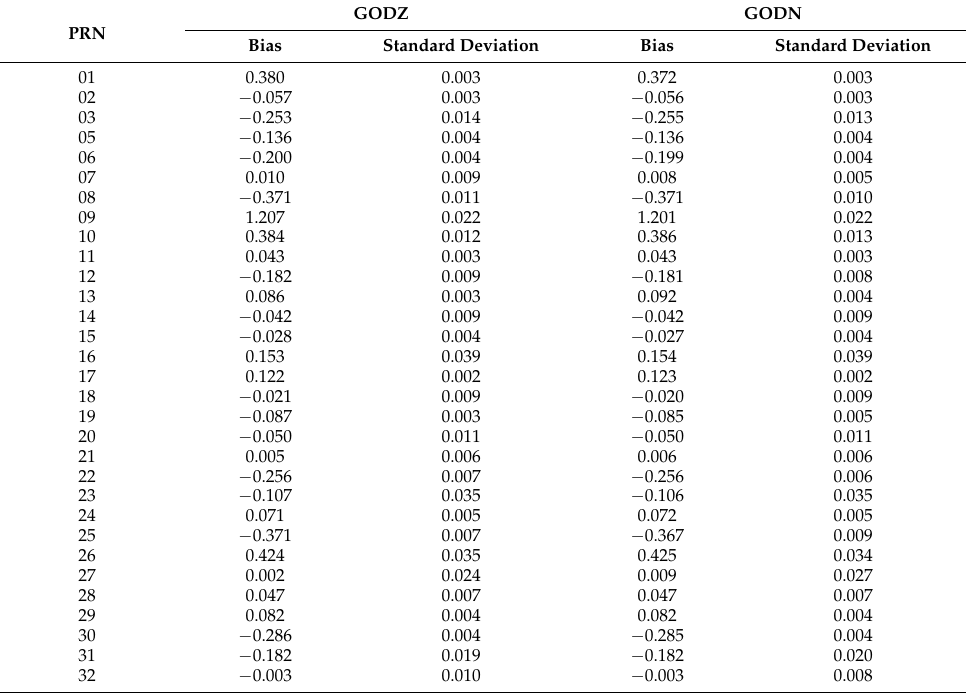
Table A1. Statistics of Figure 8. Differences in GB ionospheric delays for all of the observed satellites computed from the receiver GODZ and GODN observations with final and real-time OC products.